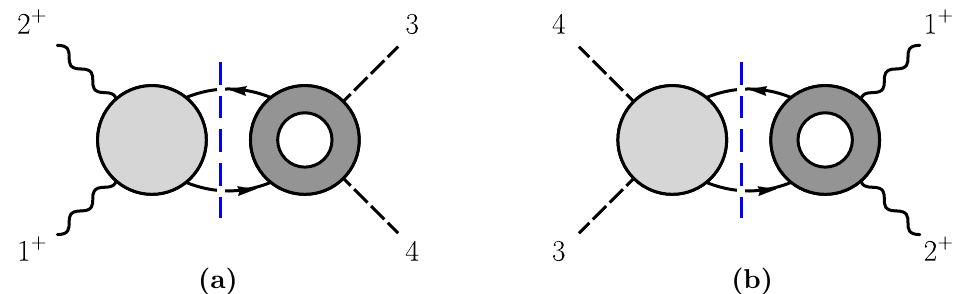
Figure 7 . (12)-channel (a) and (34)-channel (b) unitary cuts which determine the renormalization of O and O by O or O . There are no t-channel cuts for this process. In ( ’ 2 F 2 ) 1 ( ’ 2 F 2 ) 2 ( 4 ) 1 ( 4 ) 2 each diagram, the darker blobs indicate a higher-dimension operator insertion, and the dashed line indicates the integral over phase space of the particles crossing the